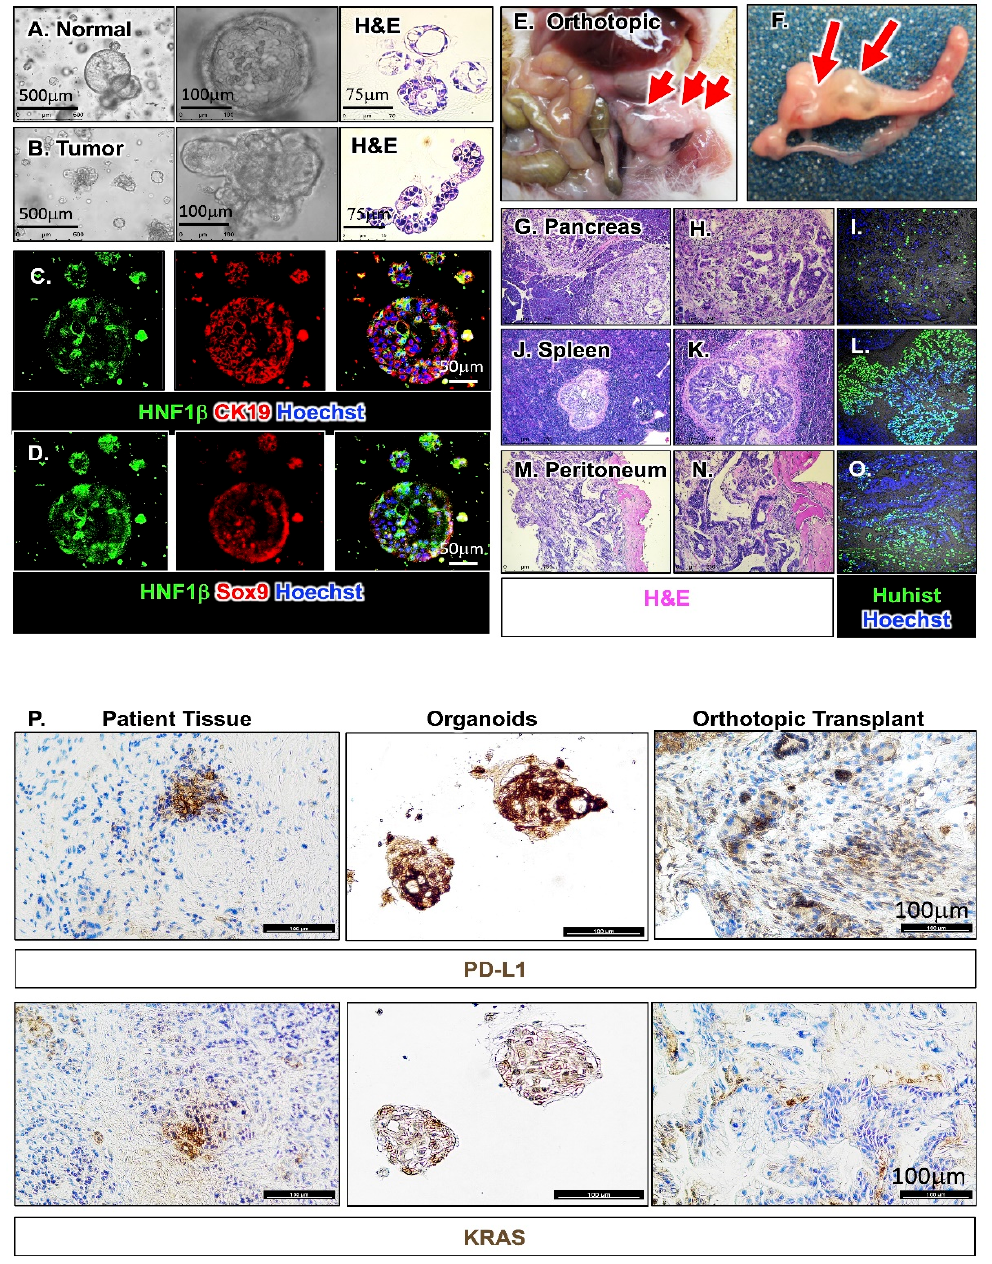
Figure 5. Generation, characterization and orthotopic transplantation of human-derived PDAC organoids. Light micrographs and H&E staining of ( A ) normal and ( B ) PDAC organoids. Immunofluorescence staining of pancreatic organoids for expression of ( C ) HNF1 β (green) and cytokeratin 19 (CK19, red) or ( D ) HNF1 β (green) and SOX9 (red). Nuclei stain shown by Hoechst in blue. Orthotopic transplantation of metastatic PDAC organoids. ( E , F ) Development of pancreatic tumors in NSG mice transplanted with PDAC organoids. H&E stains of ( G , H ) pancreas, ( J , K ) spleen, and ( M , N ) muscle. Immunofluorescence stain of human-specific histone (green) of PDAC lesions within ( I ) pancreas, ( L ) spleen and ( O ) muscle. Nuclei stain shown in Hoechst (blue). Immunohistochemical staining ( P ) of patient tissue, organoids derived from the tissue and orthotopic transplant of the organoids for expression of PD-L1 and KRAS.